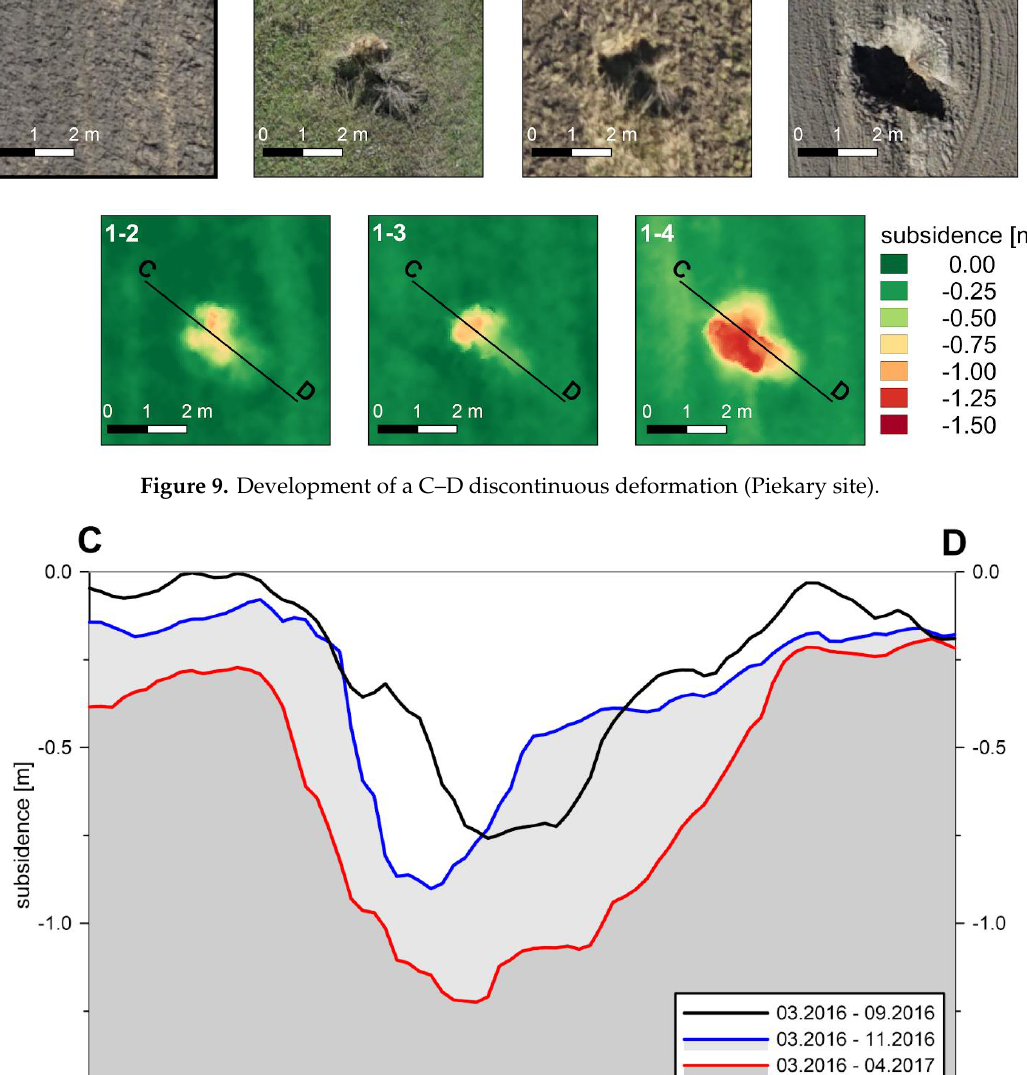
Figure 10. Subsidence profiles along a C–D discontinuous deformation based on results obtained using UAV photogrammetry (Piekary site).